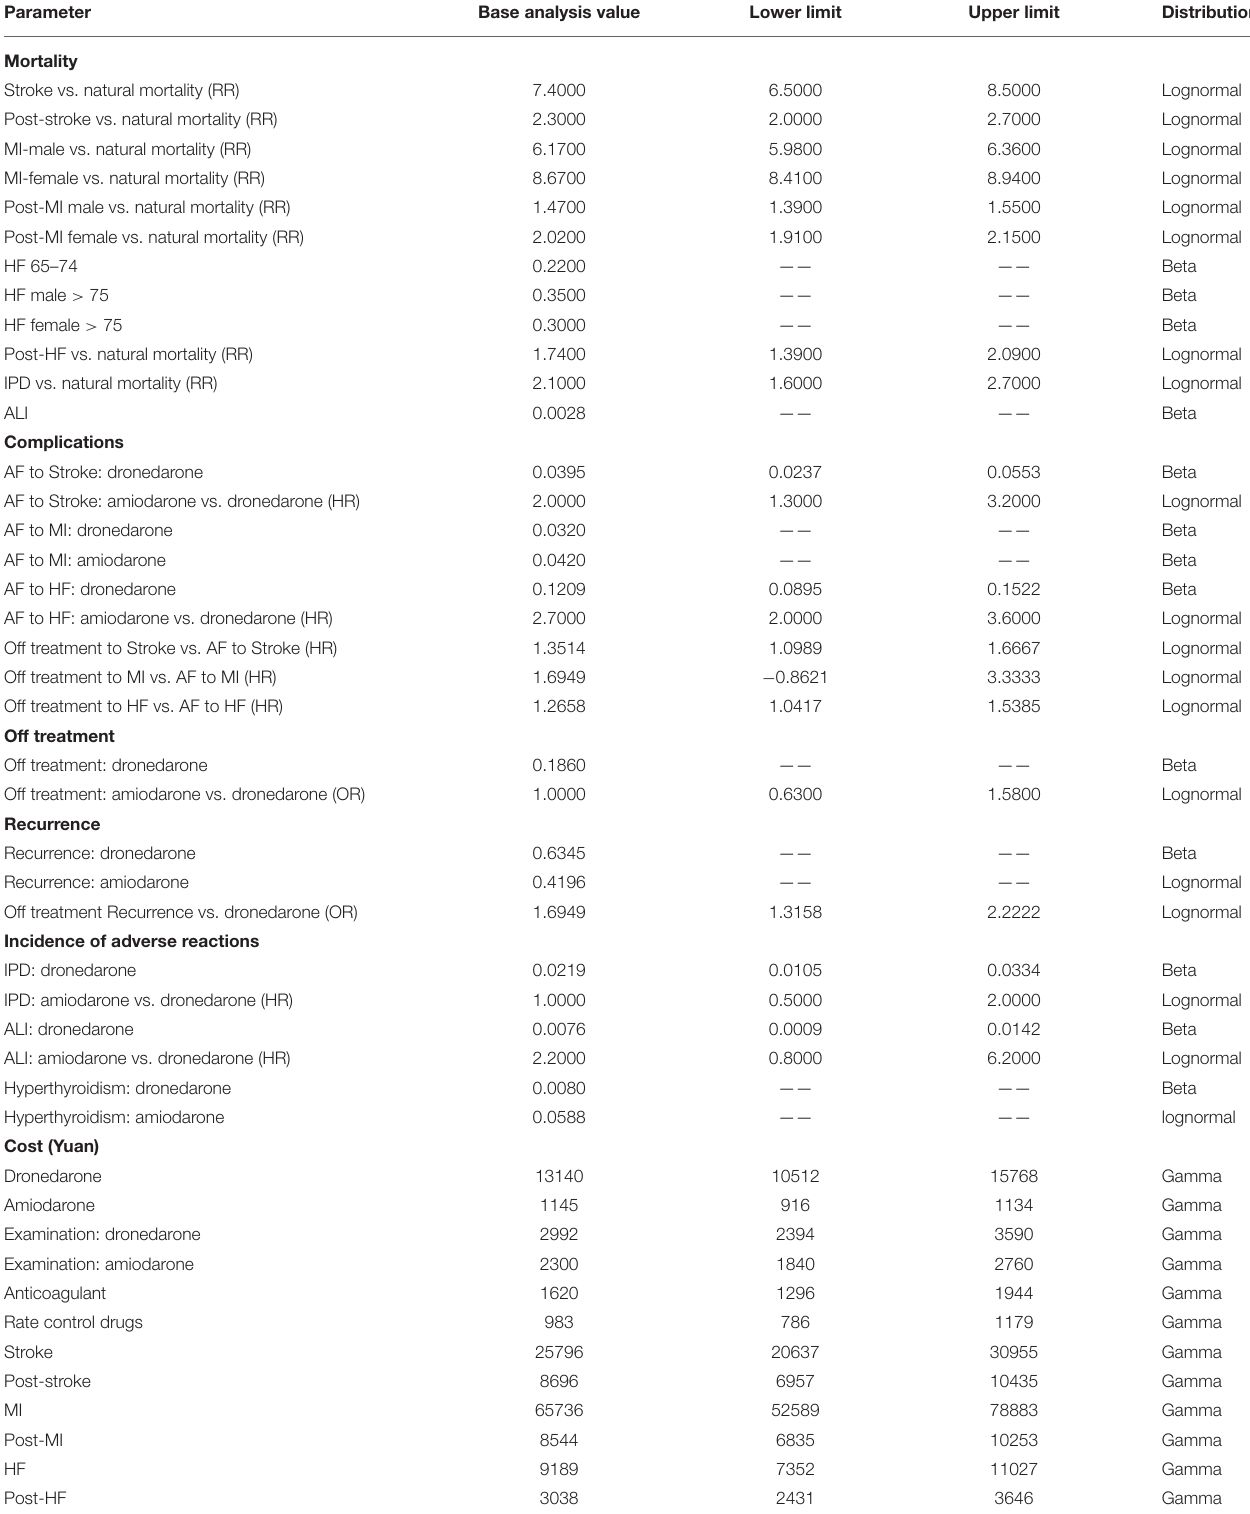
TABLE 1 | Values and distribution of model parameters.